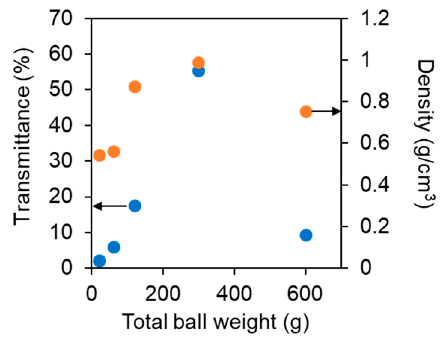
Figure 5. Dependence of transmittance at 600 nm (blue circle) and density (orange circle) of the cast film on different total ball weights for milling of chitin.